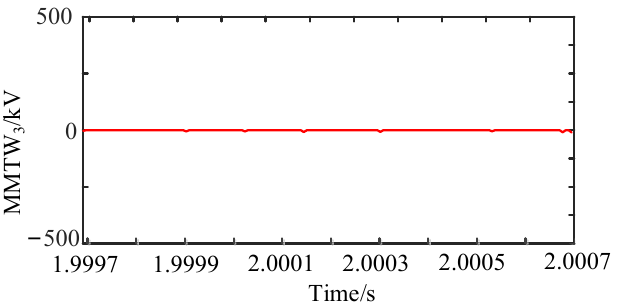
Figure 17. Wavelet modulus maximum waveform of polar ‐ mode reverse ‐ voltage traveling wave under bipolar short ‐ circuit fault of line L 2 .